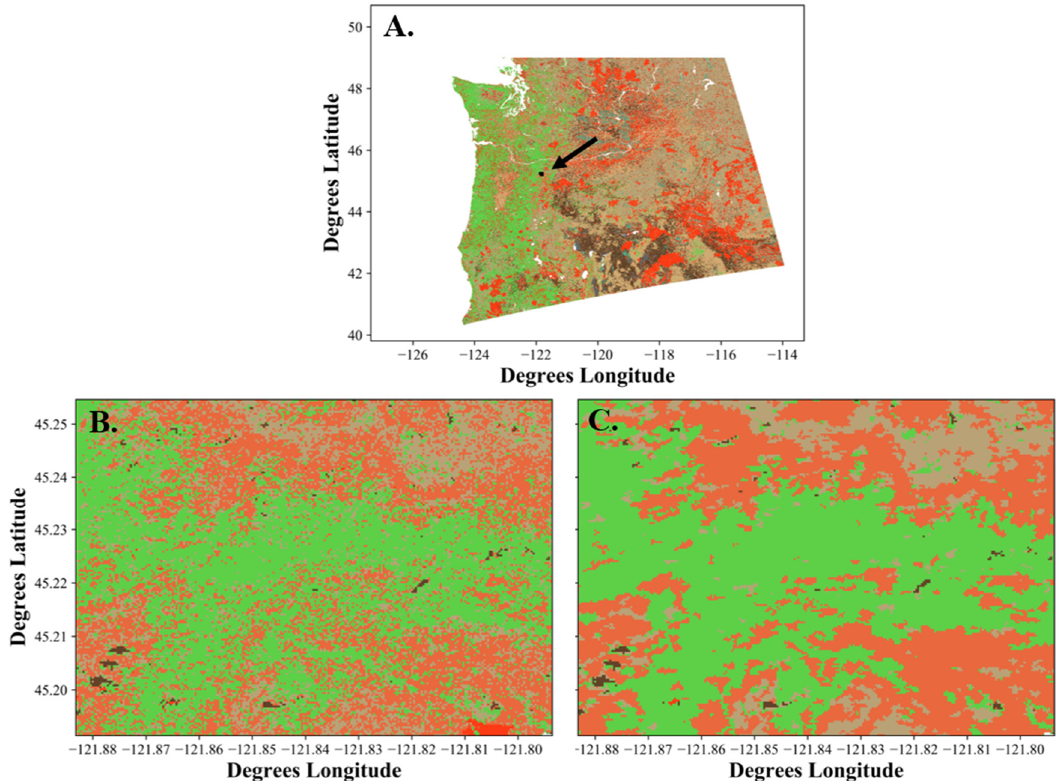
Figure 12. The segmented Existing Vegetation Type (EVT) for the entirety of the Pacific Northwest ( A ) was magnified at the area indicated by an arrow for the non-segmented EVT ( B ) and for the segmented image ( C ). Note that coloration has been simplified and uses LANDFIRE color classes (https://landfire.gov/CSV/LF140/LF_140EVT_09152016.csv, accessed 11 June 2019).